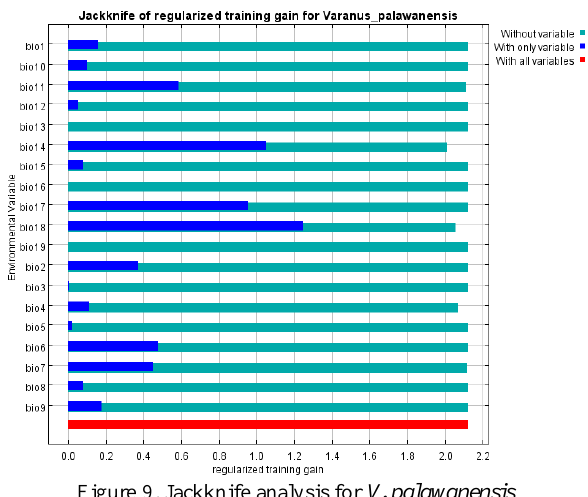
Figure 9. Jackknife analysis for V.